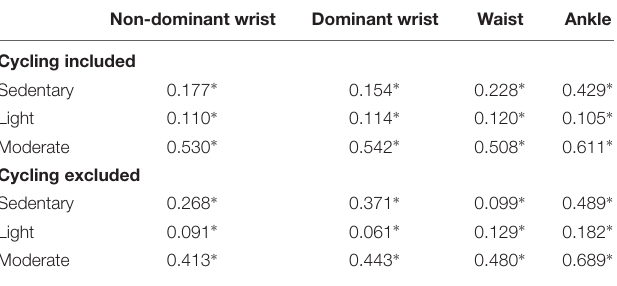
TABLE 1 | Spearman’s rank correlations between GENEActiv output and METs during sedentary, light and moderate intensity activities with and without cycling removed from analysis ( ∗ P <